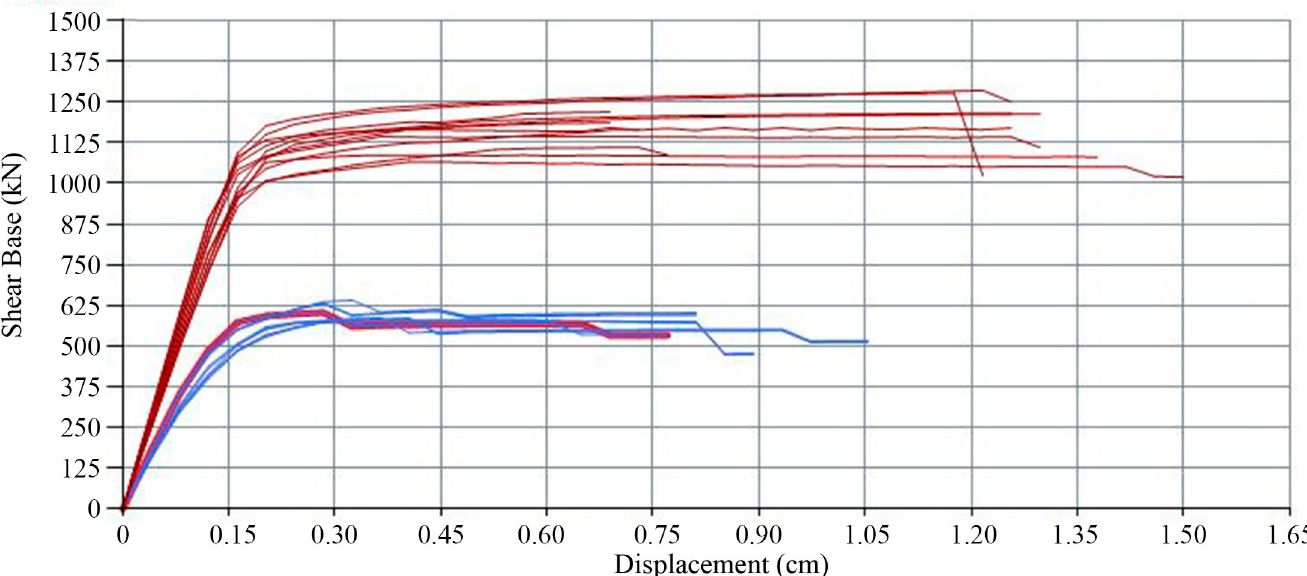
PLOS ONE | https://doi.org/10.1371/journal.pone.0223491 October 16,